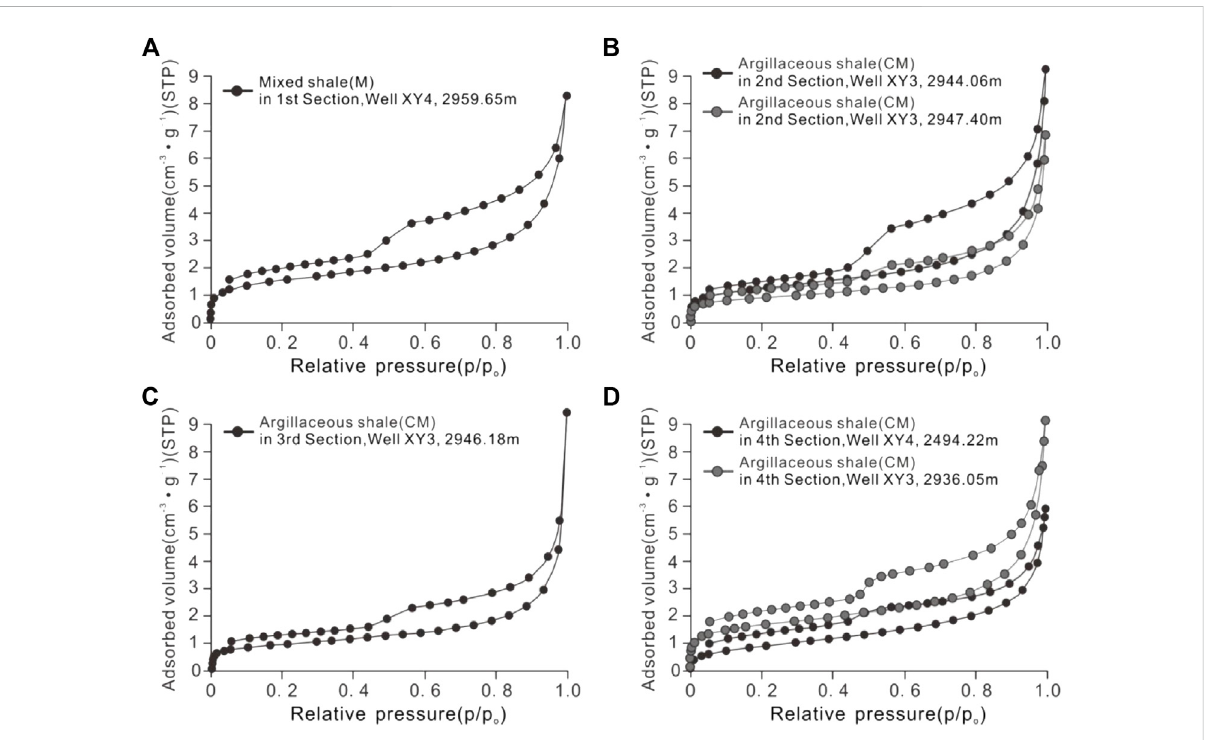
FIGURE 6 The LTNA characteristics of different shale lithofacies for the Jurassic Dongyuemiao lacustrine shale in Eastern Sichuan Basin.